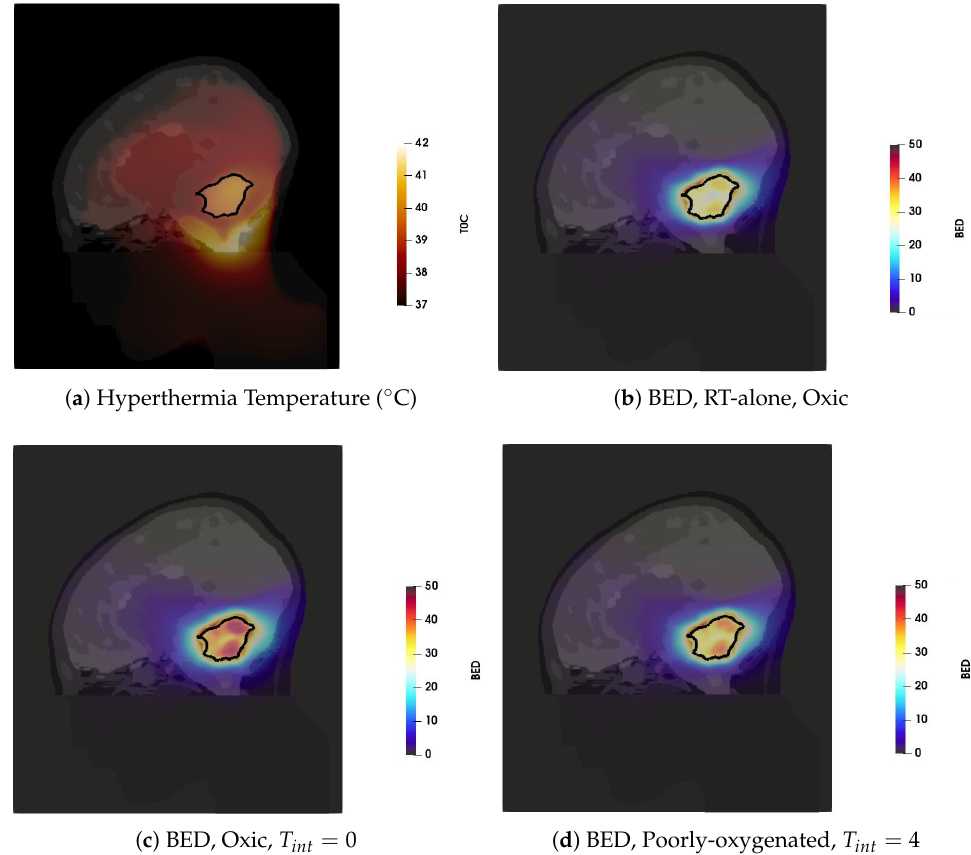
Figure 4. The thermal and BED distributions in the sagittal plane ( a ) Temperature distribution. ( b ) BED for RT plan with the total dose of 15 Gy delivered in five-fractions ( c ) BED of the combined plan for the well-oxygenated tumour and sequential administration with T int = 0 ( d ) BED of the combined plan for the poorly oxygenated tumour and HT administration 4 h after